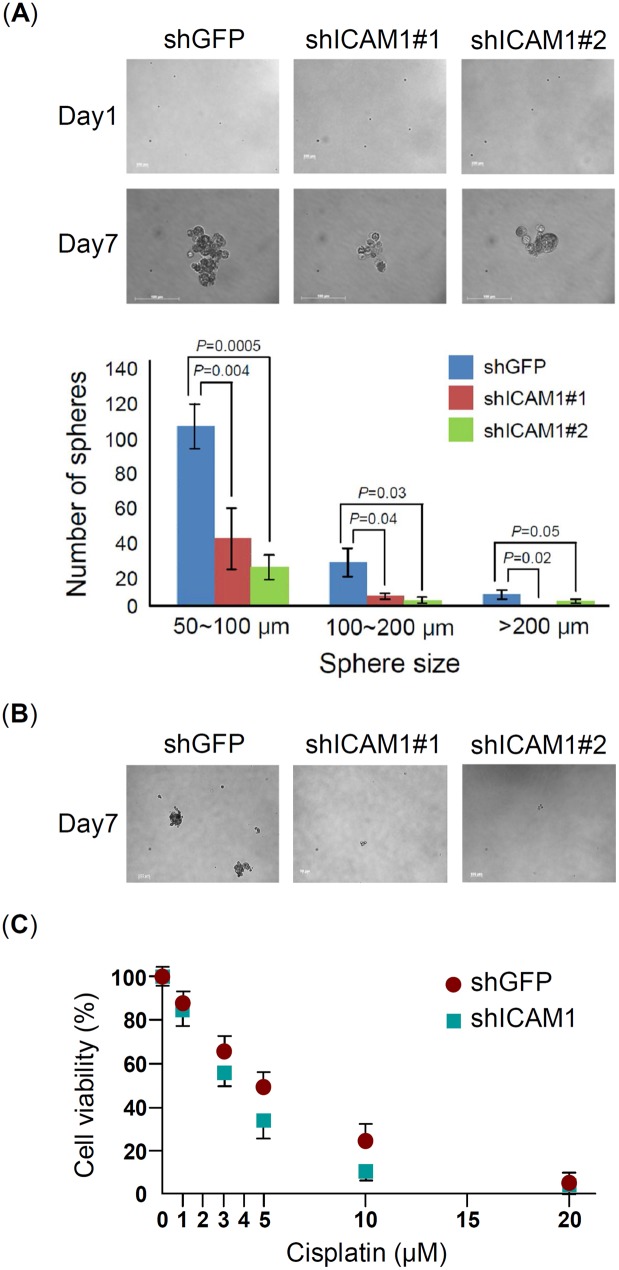
ICAM1 increases sphere formation and drug resistance of CE146T.The assays of (A) primary sphere formation and (B) secondary sphere formation were performed in CE146T with or without ICAM1 knockdown. Sphere number and size were observed and counted of primary at 7th day culture. (C) Drug resistance analysis. CE146T-shGFP and ICAM1-shICAM1#1 were treated with various doses of cisplatin for 24hr, and cell viability was measured using MTT assay. Each experiment was performed in triplicate (mean ± SD).